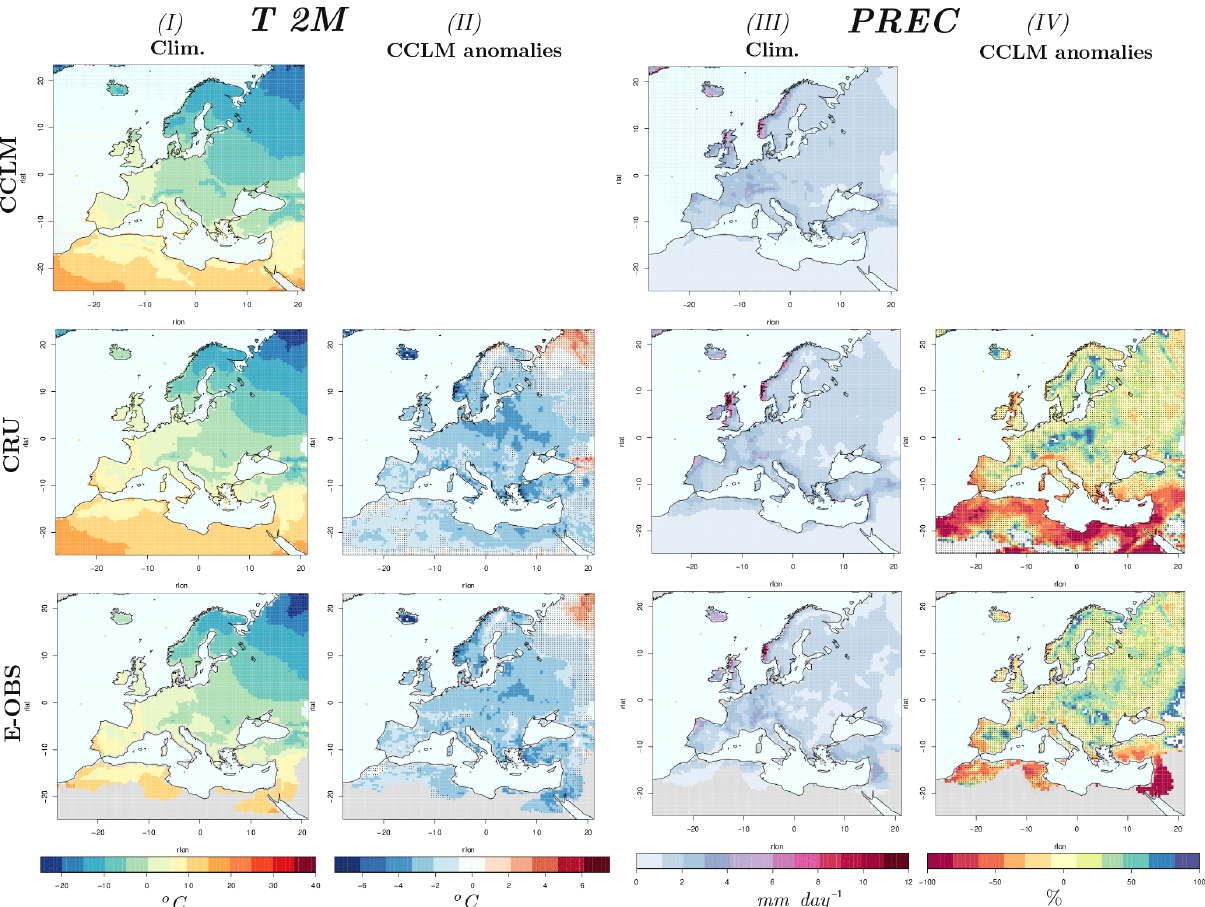
Figure 3. Analysis of Winter seasonal means of 2m temperature (left panel) and Precipitation (right panel) for the period 1991–2000. The first column of each column (I, III) shows the mean climatology for the investigated period as represented in the three considered data sets: the CCLM in the first row, the CRU in the second and the E-OBS at the bottom. The second columns show (II, IV), instead, the biases between the CCLM results and the respective observational data sets. The area with a point represent the grid cells where the anomalies between the two data sets are not significant, according to a Student’s t test, at a significance level of